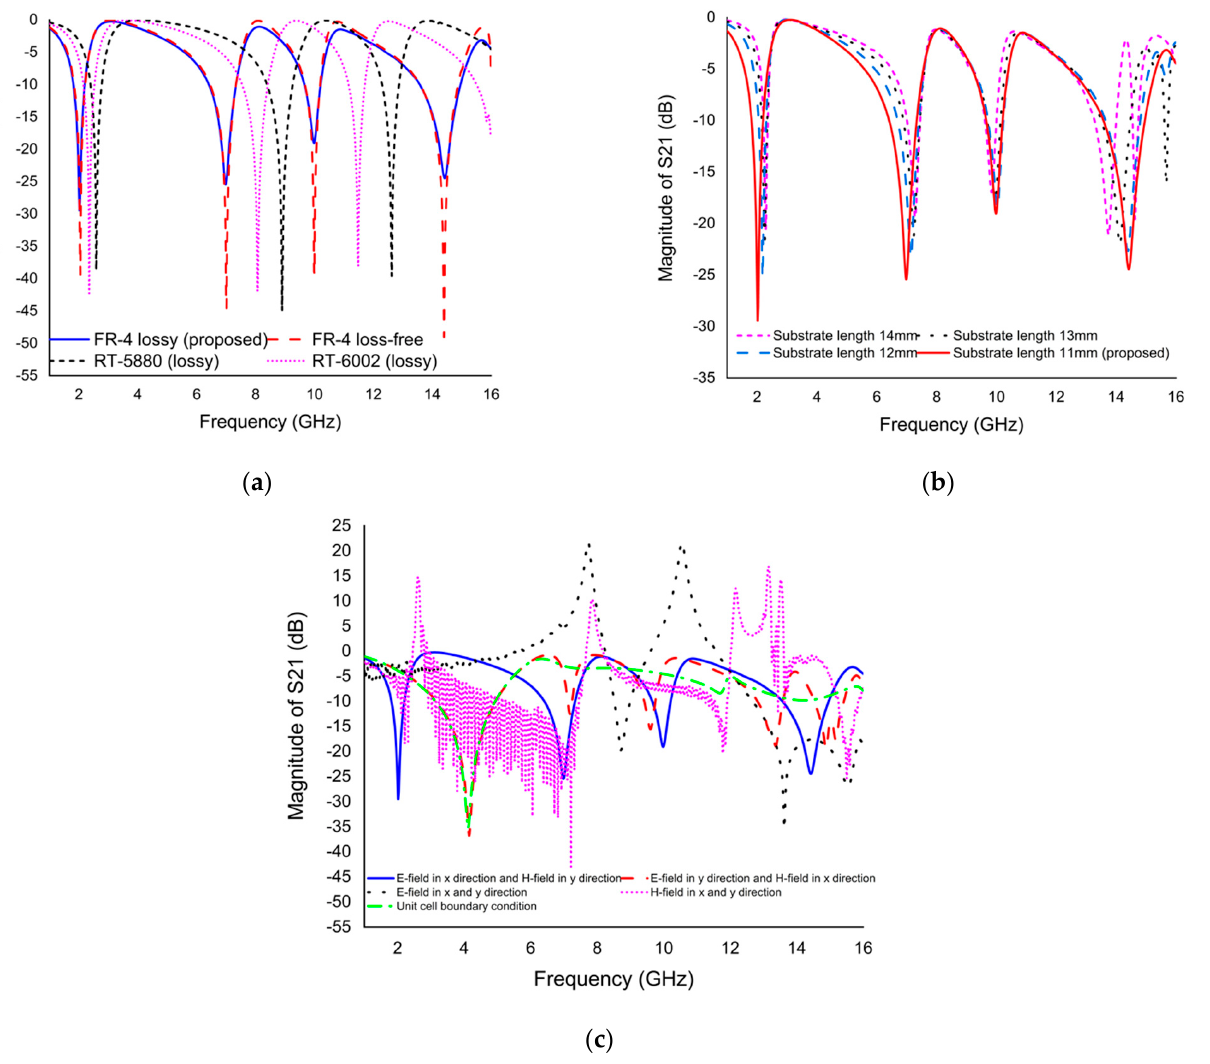
Figure 6. The S21 plot for ( a ) effect of substrate material, ( b ) effect of substrate length, and ( c ) the effect of different boundary conditions.